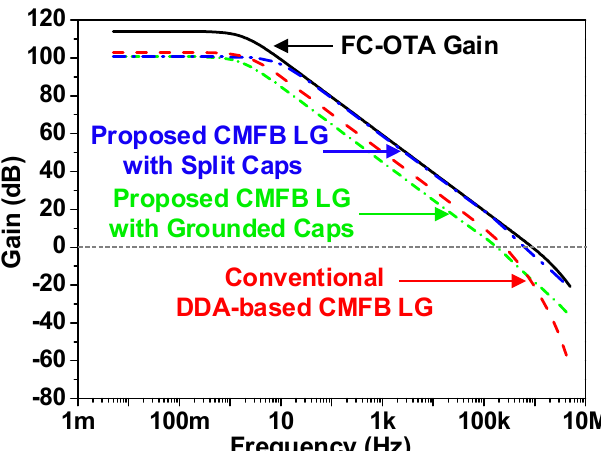
Figure 6. Loop gains of the conventional DDA-based CMFB and proposed CMFB with and without the split capacitor network.